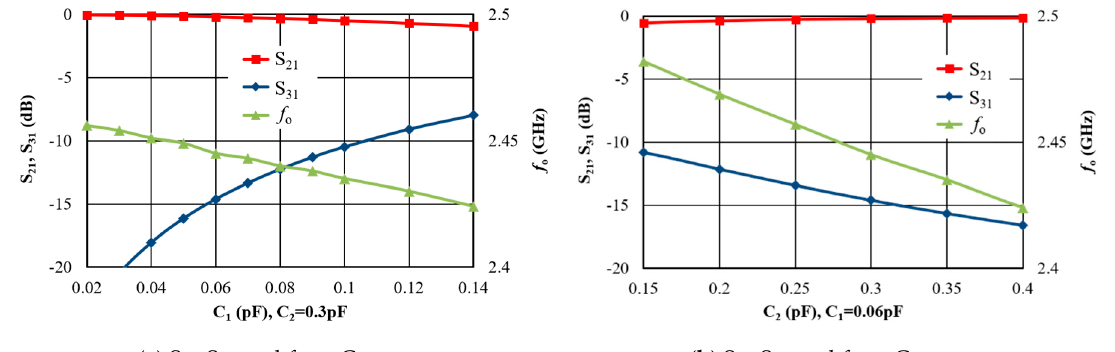
Figure 4. Calculated S 31 , S 21 , and f o .